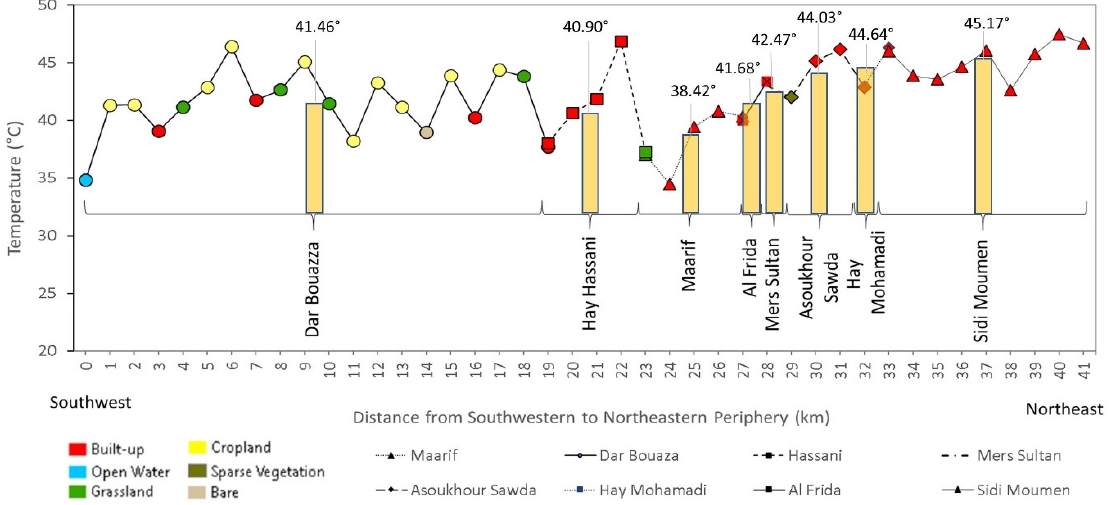
Figure 16. Surface temperature cross section along a southwest-northeast transect across eight major communes in Casablanca (see Figure 15). The light orange bars represent average temperatures for each commune along the transect and the numbers indicate the average temperature.